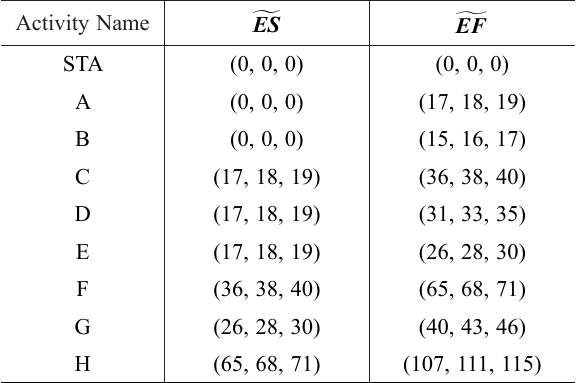
Fig. 6. Matrix B – Time factor relationships for the ji predecessor activities